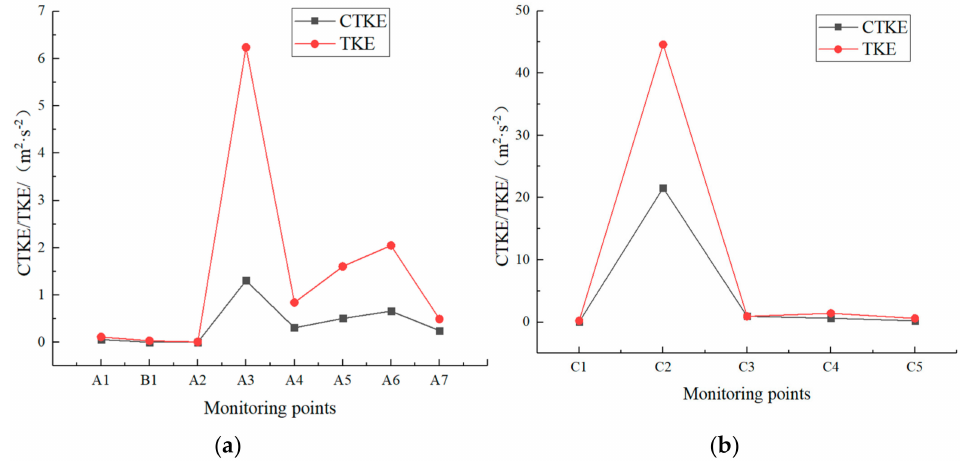
Figure 15. Turbulent kinetic energy (TKE) and coherent turbulence kinetic energy (CTKE): ( a ) A1–A7; and ( b )